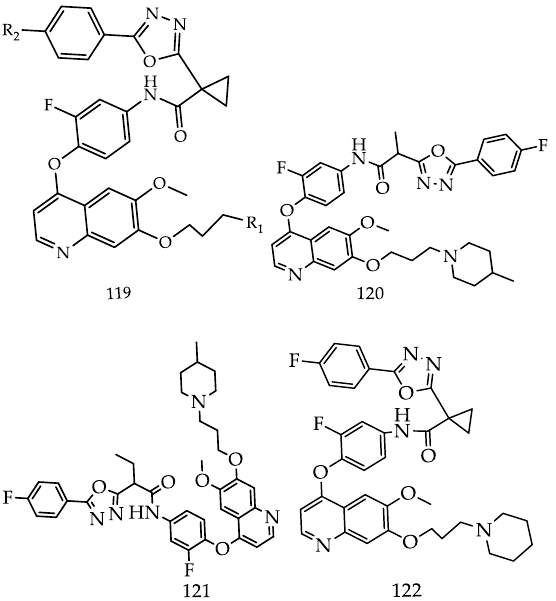
28 of 43 Table 3. The EGFR kinase inhibitory activity of substituted 1,3,4-oxadiazoles . Compd. No.